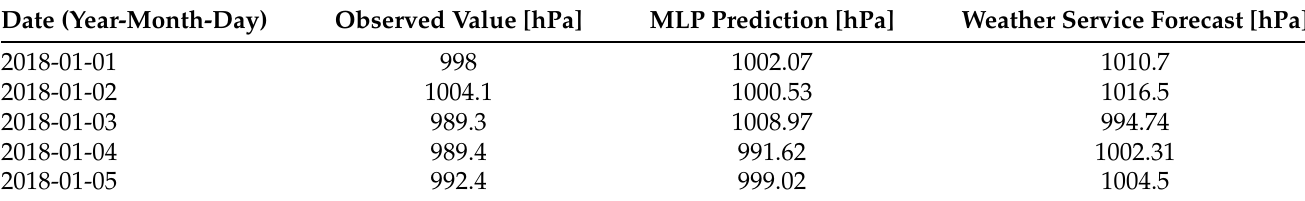
Table A19. Comparison of MLP forecast and weather service for the mean daily atmospheric pressure.